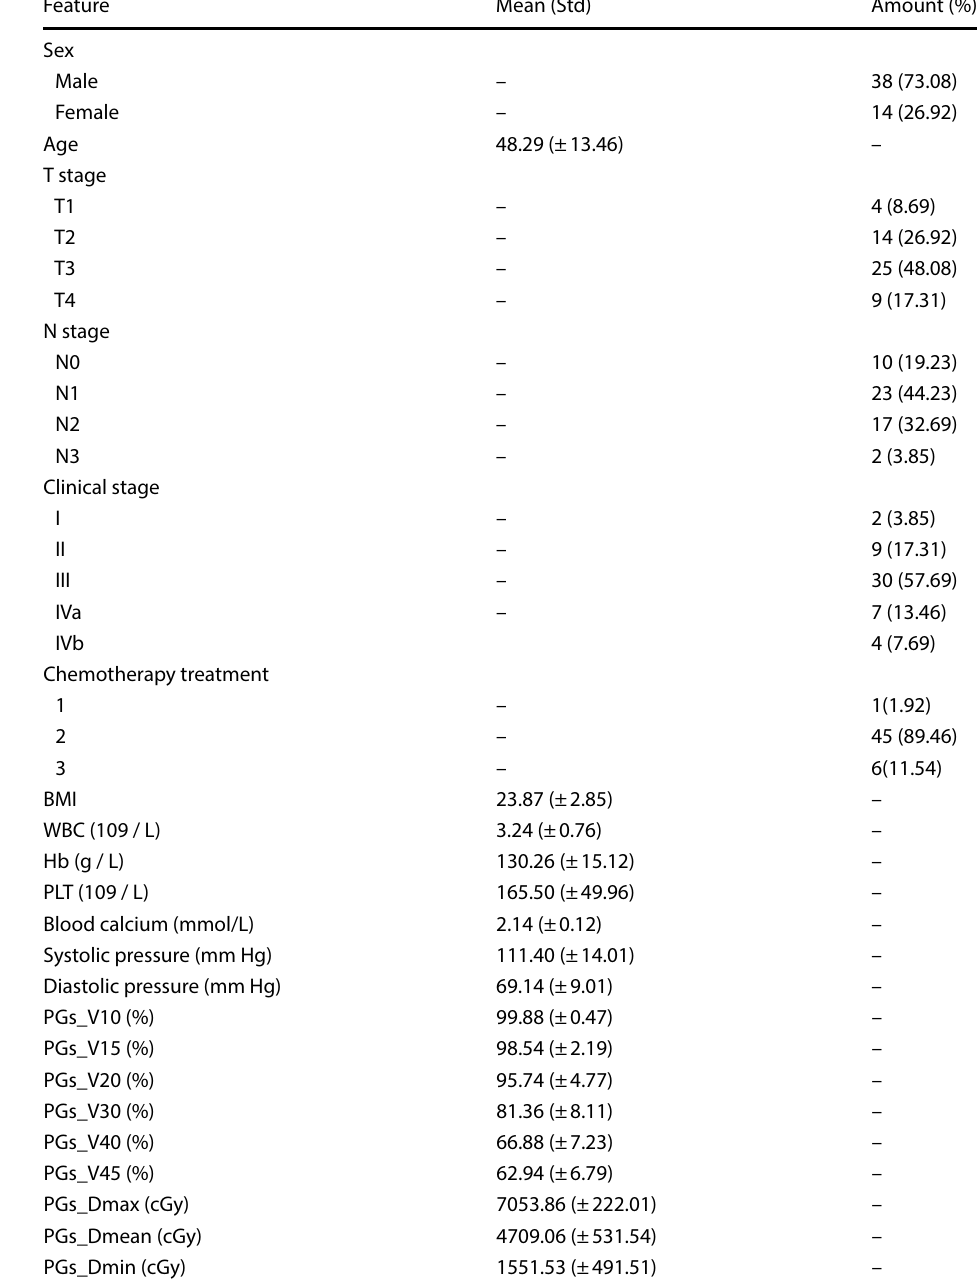
Table 1 Statistics of DVH criteria and clinical